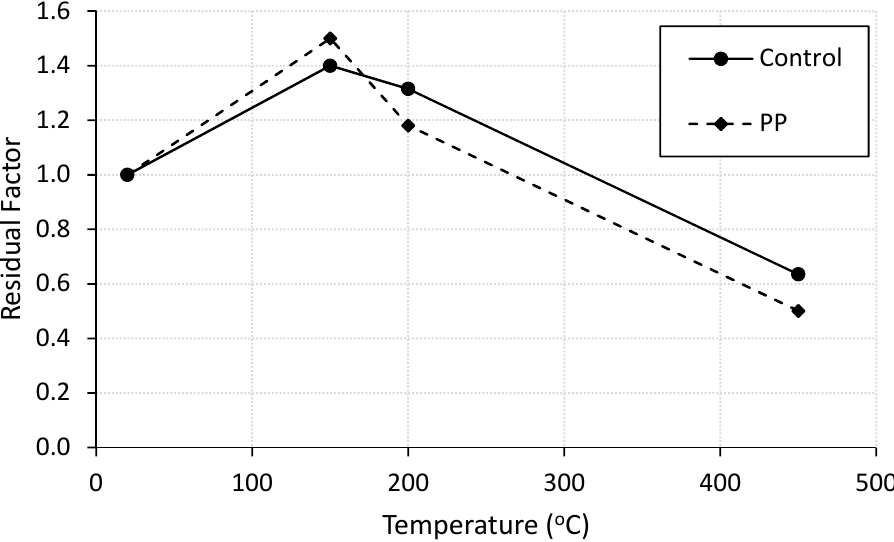
Figure 4. Residual flexural strength factor for control and fiber-reinforced specimens.